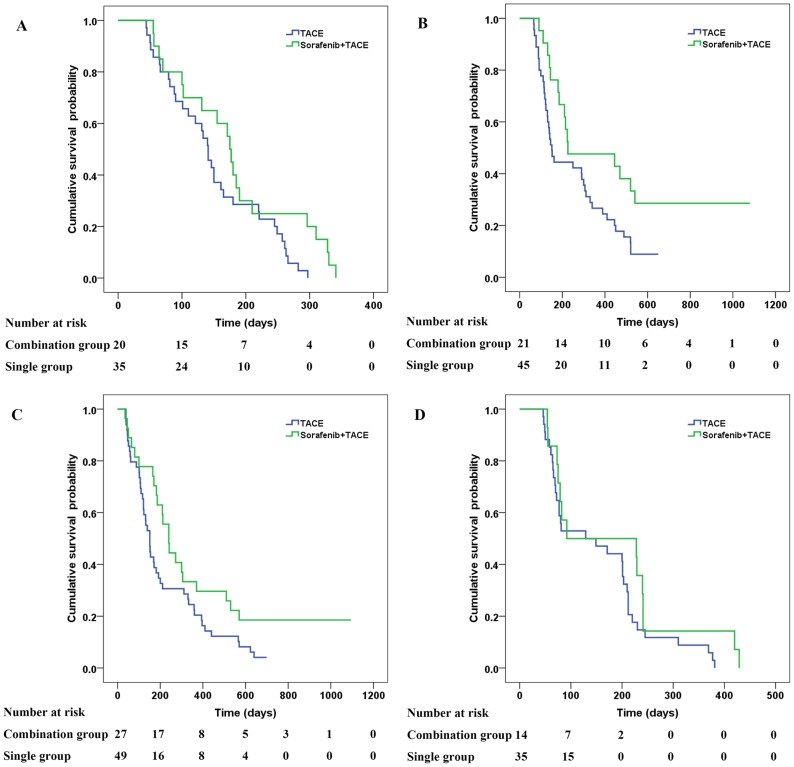
Kaplan–Meier analysis of OS of different subgroups of the combined and monotherapy groups.(A) Kaplan–Meier curves for OS of the combined and monotherapy groups for patients with main portal vein thrombosis (5.8 months vs. 4.7 months, respectively; P = 0.06). (B) Kaplan–Meier curves for OS of the combined and monotherapy groups for patients with portal vein branch thrombosis (7.5 months vs 5.0 months, respectively; P = 0.032). (C) Kaplan–Meier curves for OS of the combined and monotherapy groups for patients with tumor metastasis (8.0 months vs. 3.0 months, respectively; P = 0.045). (D) Kaplan–Meier curves for OS of the combined and monotherapy groups for patients with portal vein thrombosis and tumor metastasis (4.9 months vs. 3.1 months, respectively; P = 0.19).